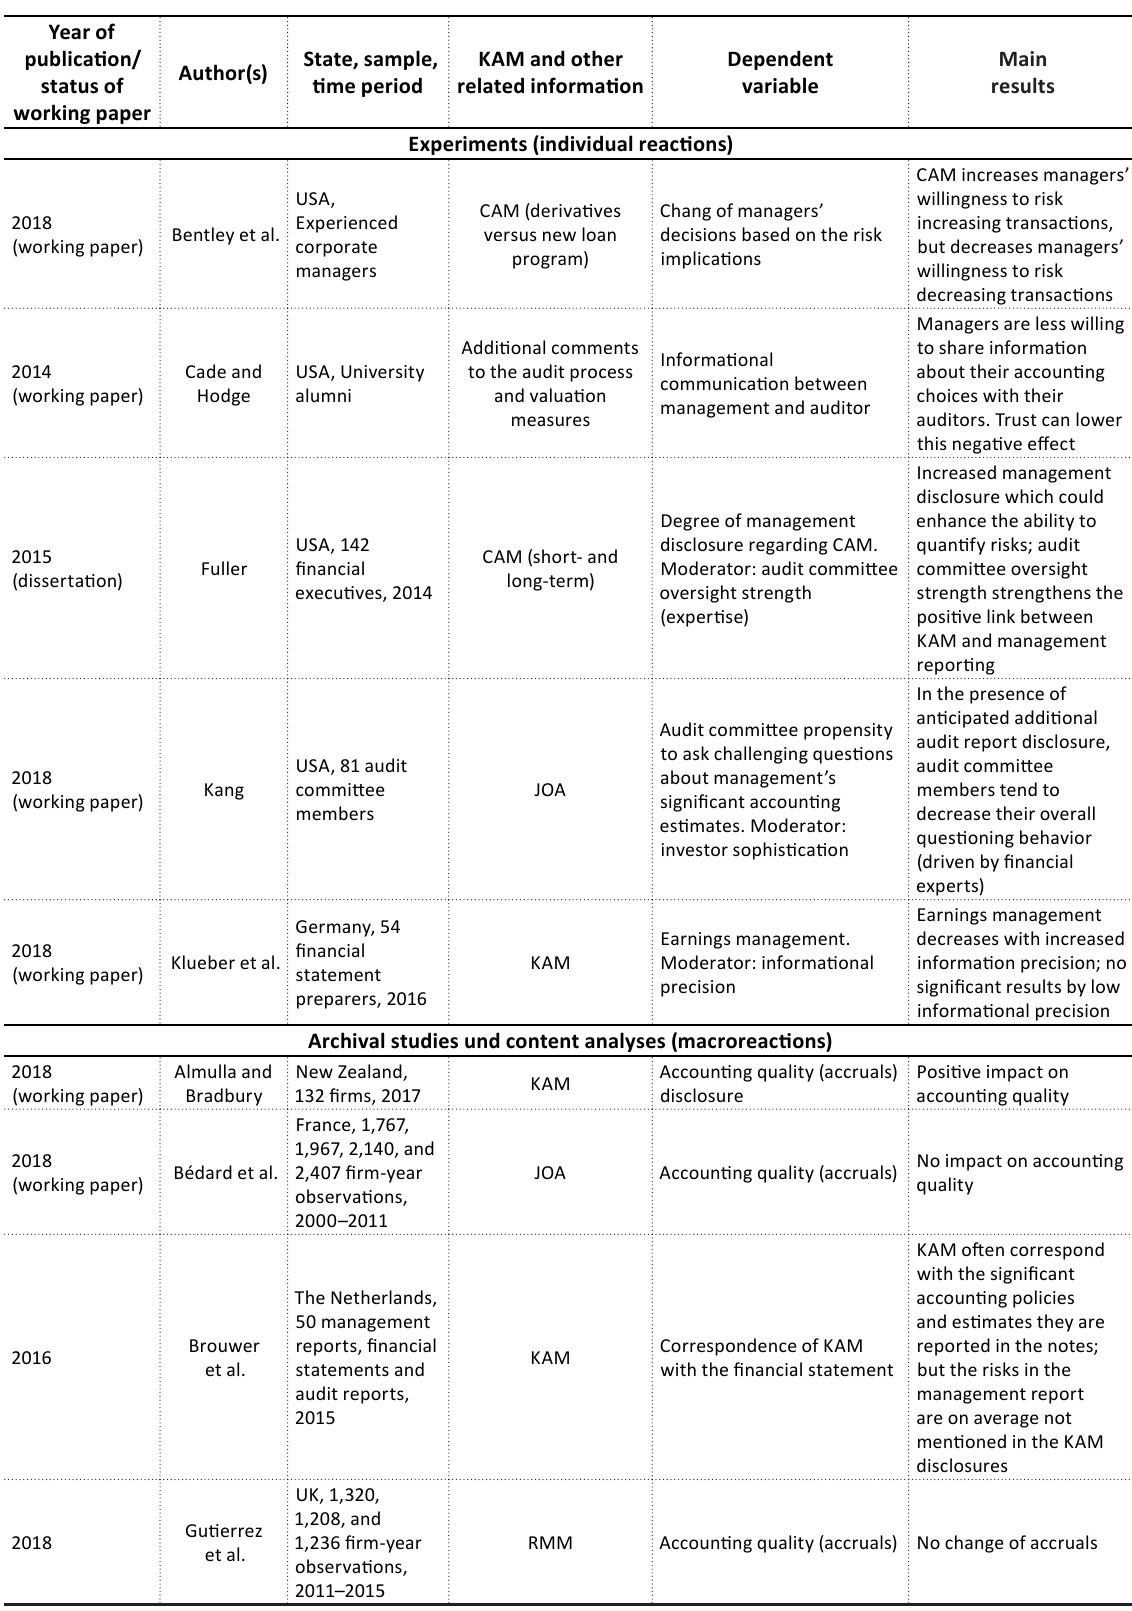
Table 6. Overview of empirical research regarding the impact of KAM and other related information on boards of